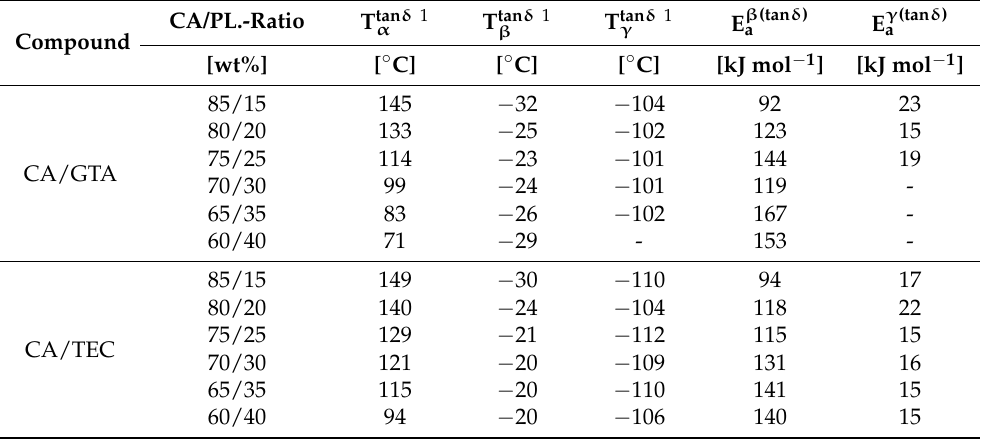
Table 3. Relaxation temperatures and activation energies of the different plasticized cellulose acetate compounds determined from the maximum peak temperature of tan δ